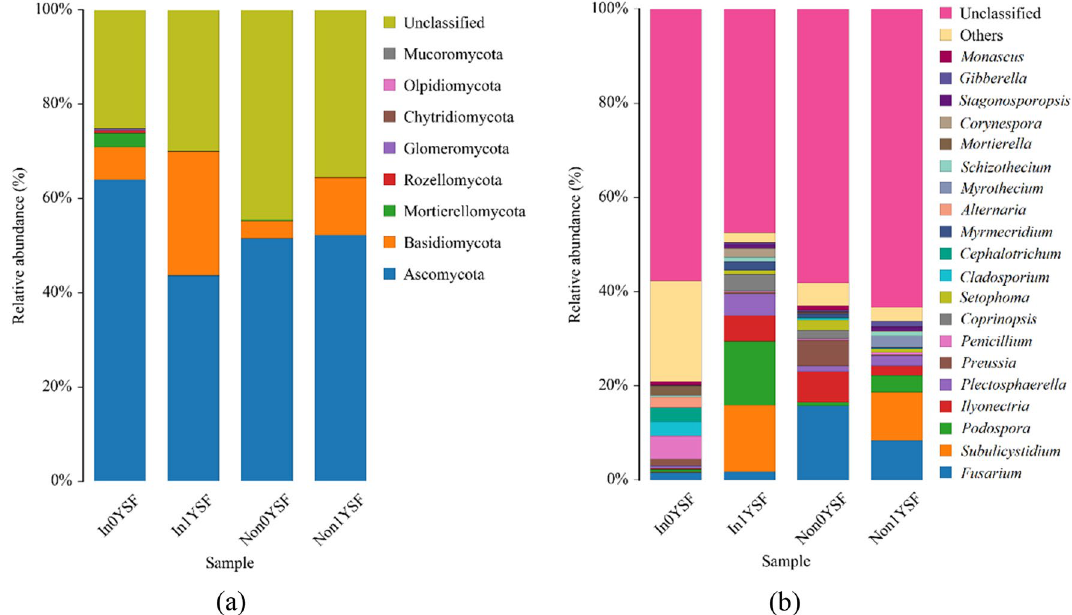
Figure 5. The composition of fungal communities at the phylum ( a ) and genus ( b ) levels. Non represents non- inoculated with R. intraradices . In represents inoculated with R. intraradices . 0Y and 1Y represent 0 year and 1 year of continuous cropping, respectively. SF represents fungi in rhizosphere